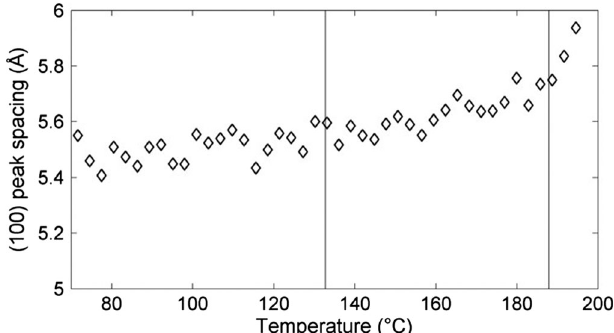
FIG. 13. Plot of the d-spacing of the (100) peak (wide angle) as a function of temperature, where solid lines correspond to the locations of the I - N and N - N phase transitions, respectively. S